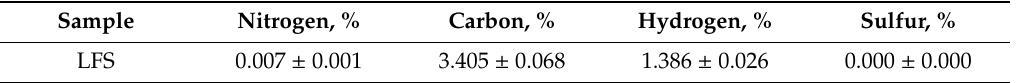
Table 4. Elemental analysis of the ladle furnace slag.